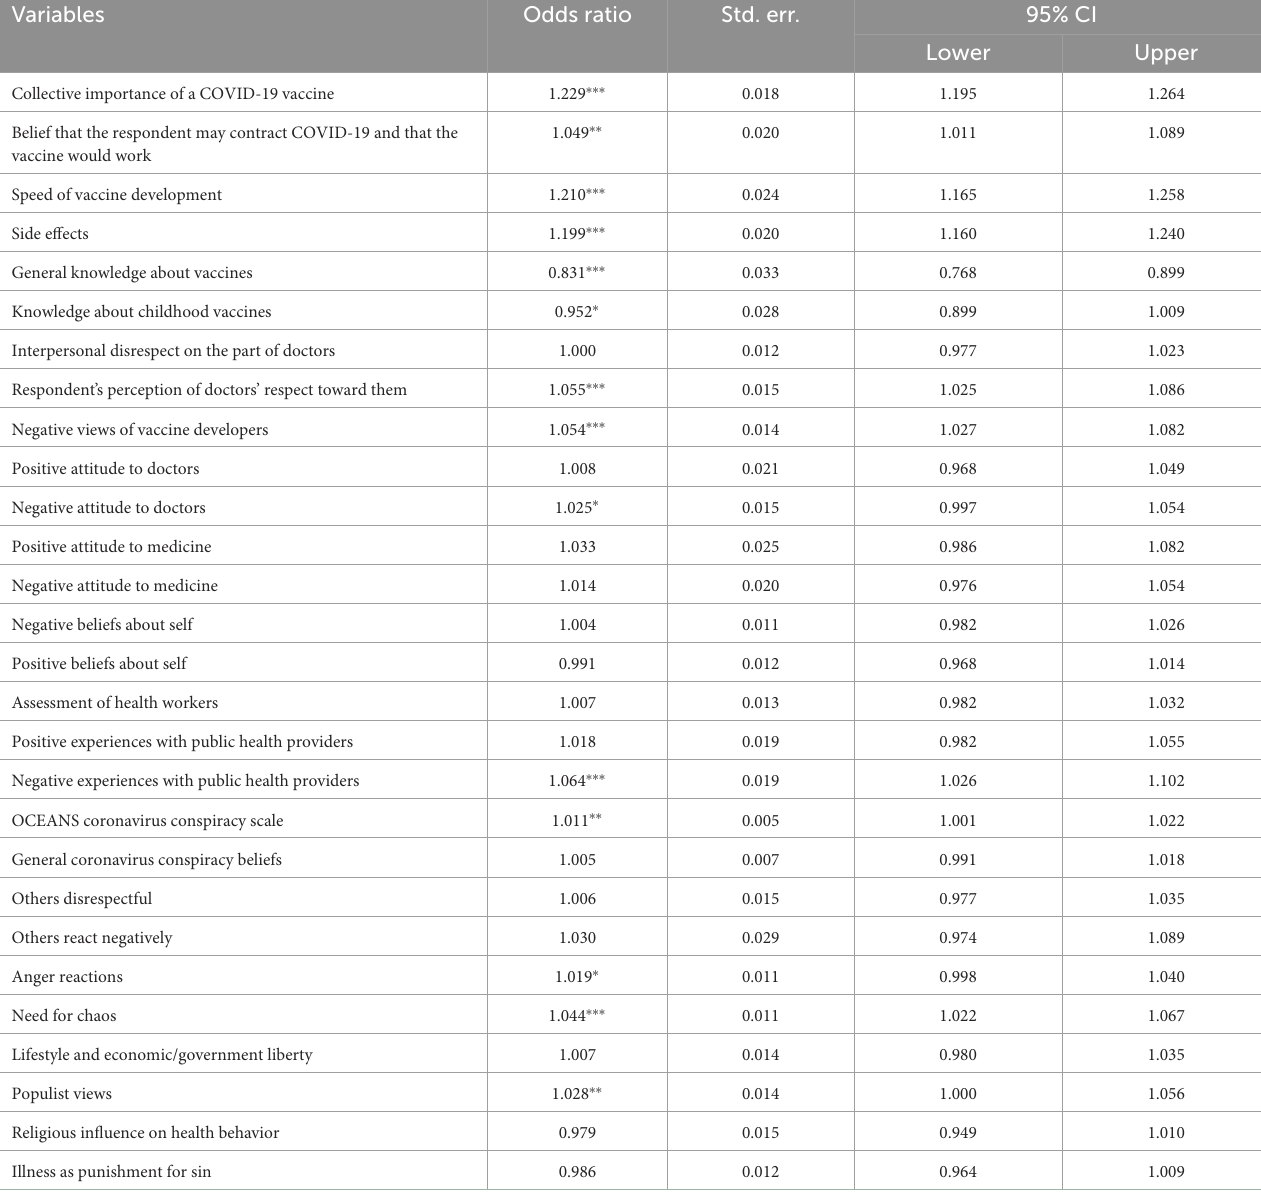
TABLE 4 Results of multivariate ordered logistic regression measuring the association of reasons for vaccine hesitancy with COVID-19 vaccine hesitancy.